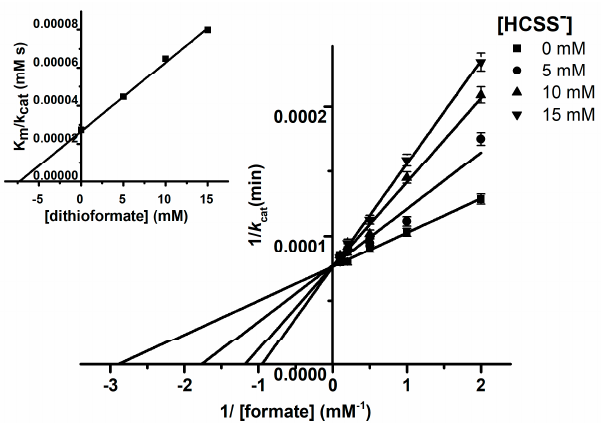
Figure 4. Inhibition kinetics of Rc FDH with dithioformate. Steady state kinetics were carried out under anaerobic conditions using 2 mM benzyl viologen ( ε 578, benzyl viologen = 8.65 mM − 1 cm − 1 ) as an electron acceptor. The assay mixture contained different concentrations of formate (0.05–5 mM), dithioformate (0–15 mM) and 2 mM benzyl viologen in 100 mM Tris-HCl buffer, pH 9. Photometric measurement at 578 nm was carried out for 60 s after the addition of 30 nM Rc FDH.